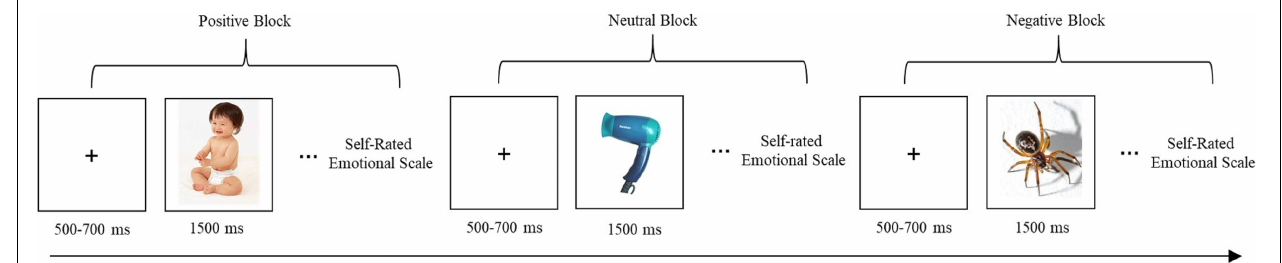
FIGURE 2 | Image presentation and self-rating procedure. Blocks were presented in random order among the participants.